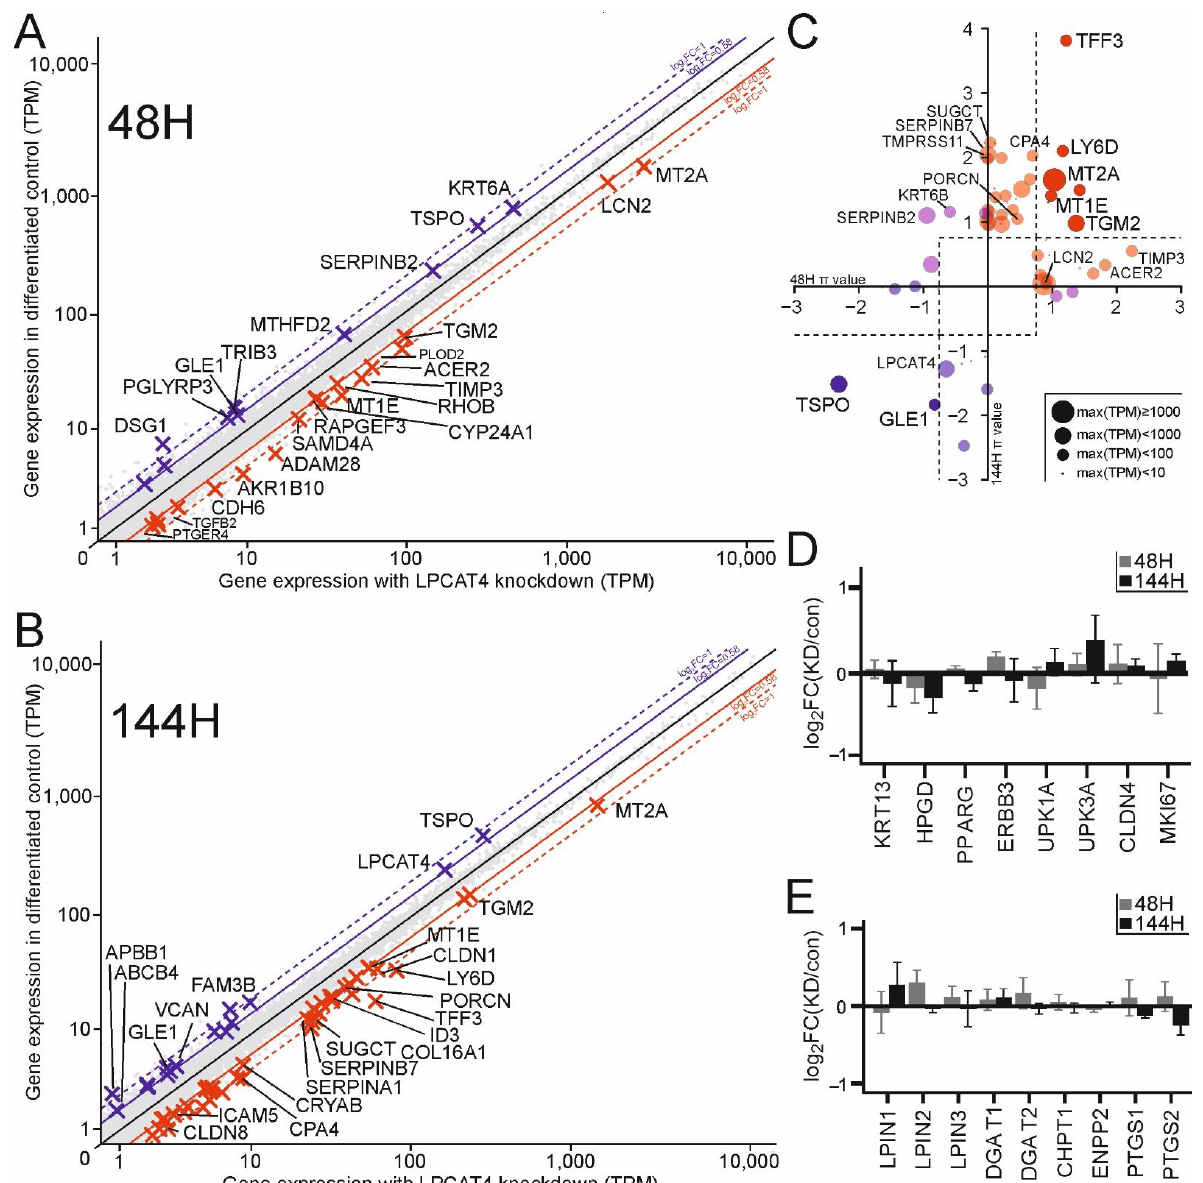
Figure 5. Specific transcriptomic effects of LPCAT4 knockdown. Gene expression plot for 4 donor- matched knockdown and control cultures 48H ( A ) and 144H ( B ) after initiation of the NHU differ- entiation protocol. Genes upregulated following LPCAT4 knockdown are indicated by red crosses and named when expression increases by at least 50% with a corrected p value less than 0.05 (two targets with smaller font are of interest have corrected p values less than 0.10). Genes downregu- lated by at least 50% with a corrected p value less than 0.05 are marked by blue crosses. Consistent transcriptomic changes between time points are indicated in ( C ) using π scores and scaled points based on maximum expression values. Bright red and blue indicate significant changes at both time points, transparencies represent significance at one time point. Pink circles represent genes where the fold-change direction switched between time points. There were no significant differences in differentiation markers at either time point ( D ), or in genes of lipid modifiers perhaps impacted by the reduction in LPCAT4 metabolic activity ( E ). Transduced donor backgrounds 1–4 (Figures 3 and 4) were used for transcriptomic